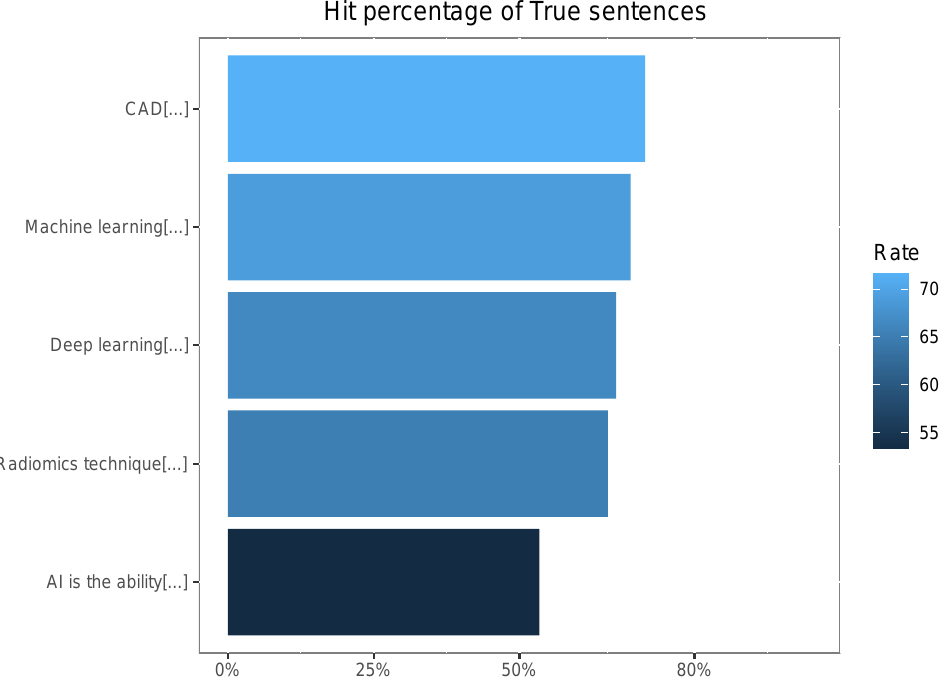
Figure 1. Percentage of correct answers in true sentences with an average accuracy of 65.1%. Abbre- viations of True sentences used in Figure 1 due to their length: CAD [(computer-aided diagnosis): these are computer-aided diagnosis tools developed to detect, to segment and to classify lesions or